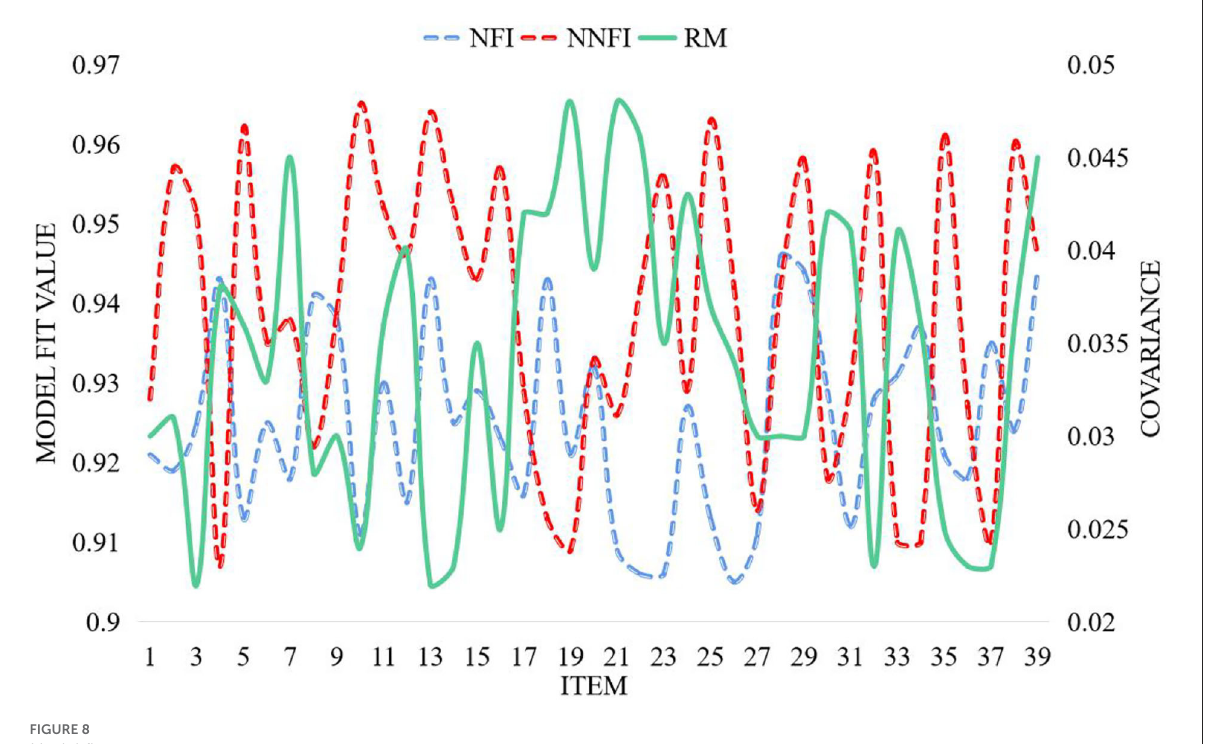
FIGURE8 Model fit